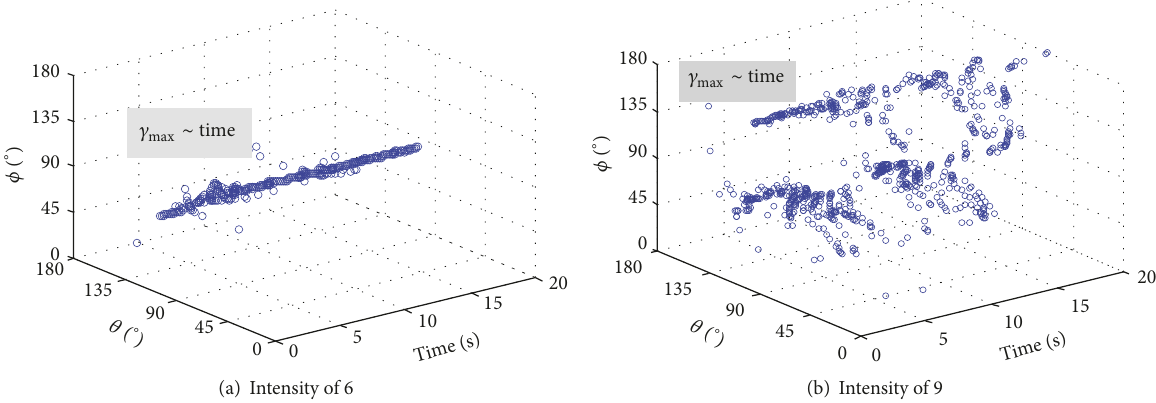
Figure 14: Time-varying angle of maximum shear strain at the fatigue critical point in the case of rare earthquake.